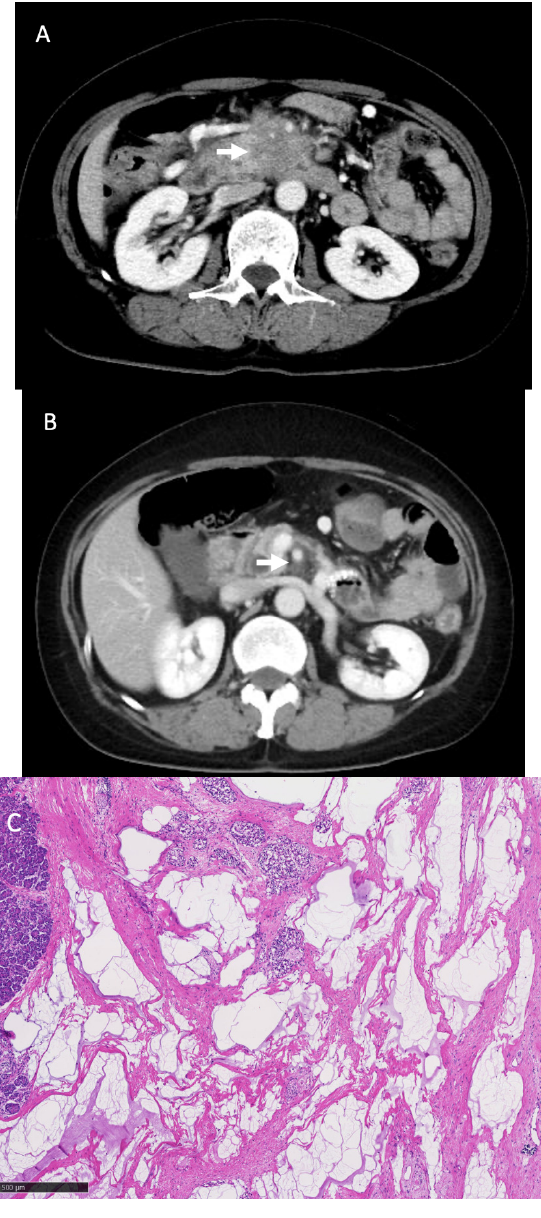
Figure 4. Computed tomography (CT) findings of Patient #6. ( A ): CT findings before chemotherapy showed that the pancreatic head tumor involved the superior mesenteric artery (SMA) (white arrow). ( B ): CT findings before conversion surgery. The high-density area surrounding the SMA (white arrow) remained slightly, although the tumor itself disappeared. ( C ): Pathological findings of the resected tumor showed mainly predominant fibrous tissue with fatty degeneration, mucus pool and remaining Langerhans islands, without any viable tumor cells (hematoxylin and eosin staining). These pathological findings were considered as Evan’s grade of